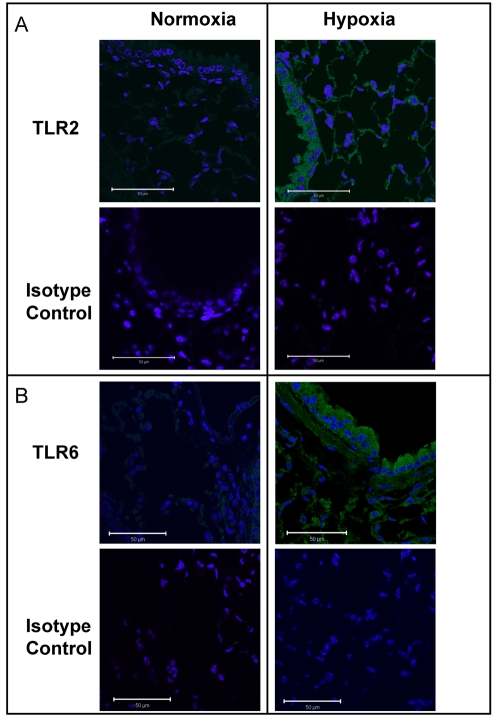
Pulmonary immunohistochemistry for TLR2 and TLR6 during hypoxia.
A and B, Lungs from mice exposed to normoxia or normobaric hypoxia (8% O2, 92% N2 for 4h) were harvested, formalin-fixed and paraffin-embedded. Sections were stained with antibodies for TLR2 and TLR6 or isotype controls. This figure is representative of three experiments in each condition.